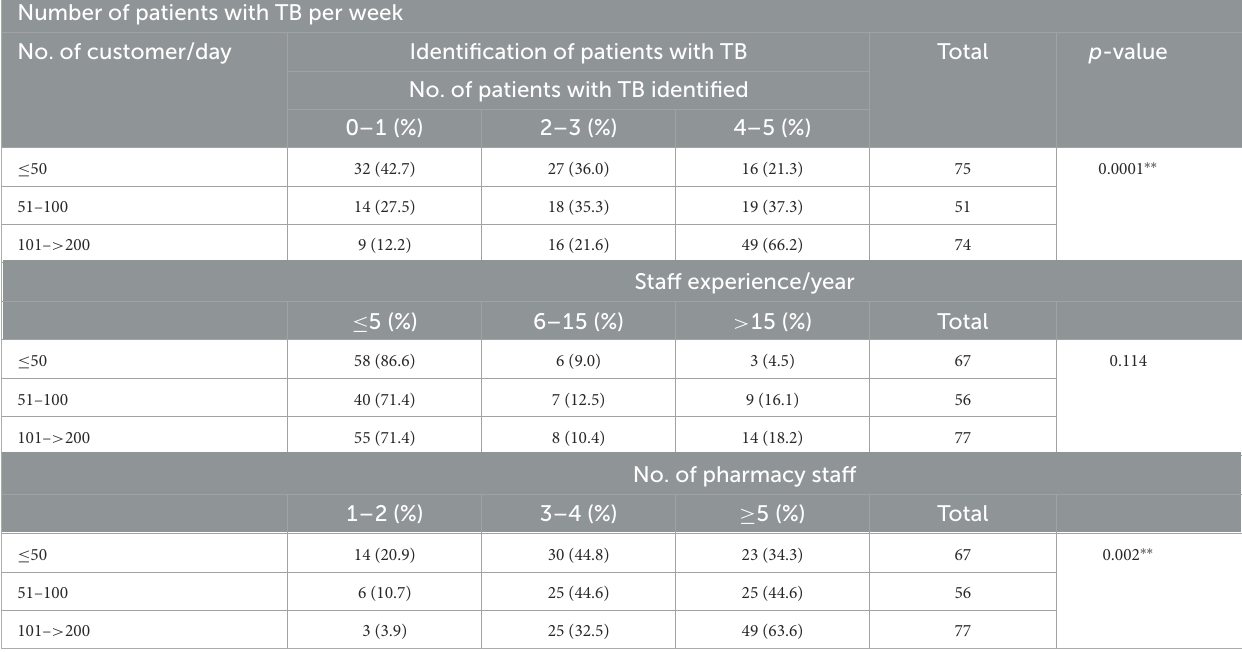
TABLE 3 Number of patients with TB per week with regard to the number of staff and their working experience. Number of patients with TB per week